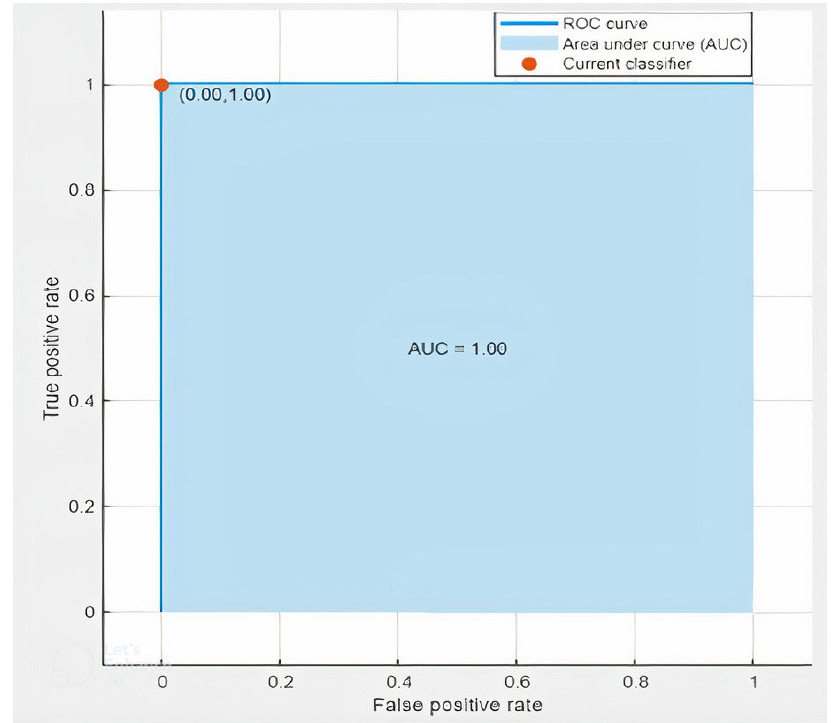
Figure 17. ROC Curve of Hardwood, Worn-out Tool, 1 mm.